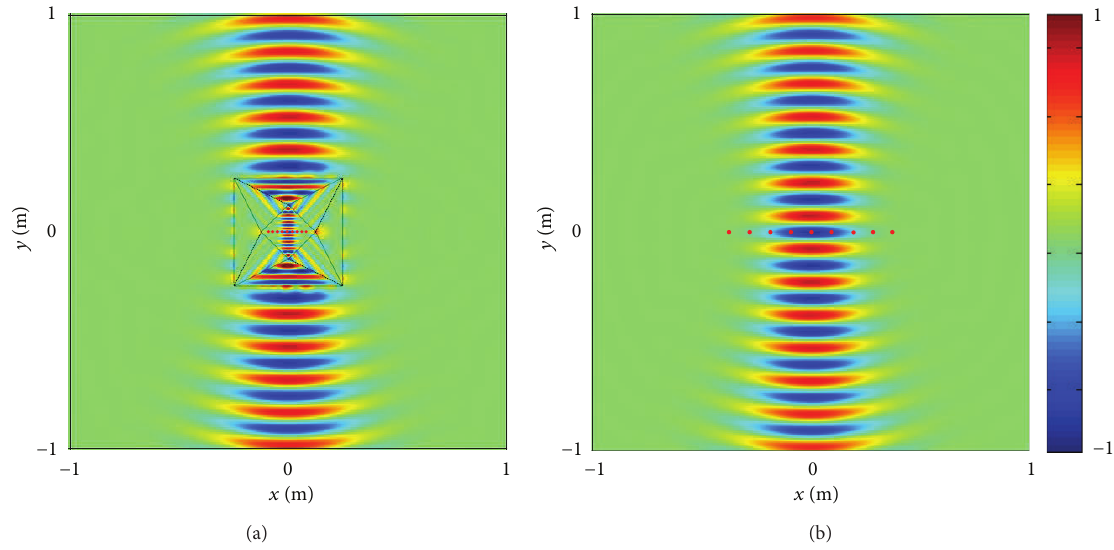
Figure 3: (a) 𝐸 𝑧 field distribution of a small antenna array with nine elements embedded in square metamaterial shell. (b) 𝐸 𝑧 field distribution of a large antenna array in free